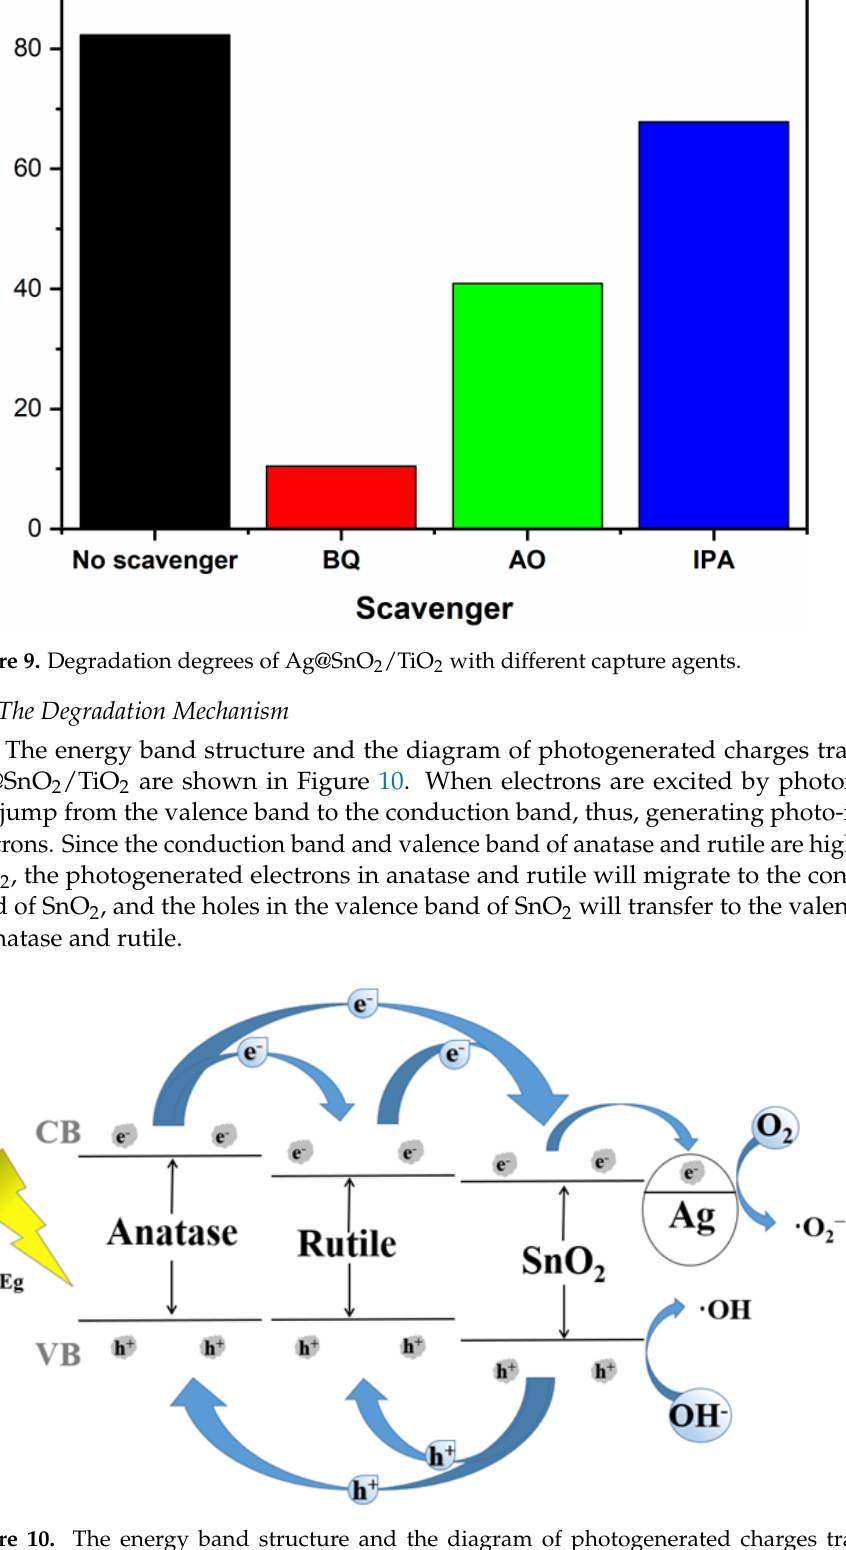
Figure 9. Degradation degrees of Ag@SnO 2 /TiO 2 with different capture agents.